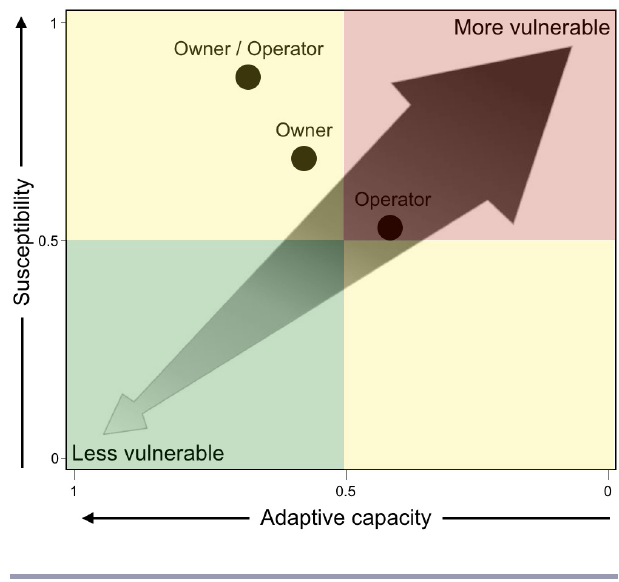
Fig. 2. Susceptibility plotted against adaptive capacity factor scores. Note that the adaptive capacity axis is flipped. The arrow highlights less vulnerable to more vulnerable stakeholder groups, as do the quadrat colors. Green = least vulnerable, red = most vulnerable, yellow = moderately vulnerable but for different reasons (either low adaptive capacity or high